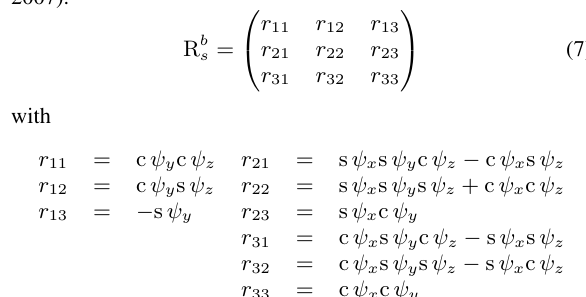
Figure 8: Absolute differences in diffuse reflectance be- tween overlapping flight strips at Ölgrube (top) and Äußeres Hochebenkar (bottom). The relatively high differences at the out- lines of the rock glaciers might stem from different acquisition dates and daytimes of the respective flight